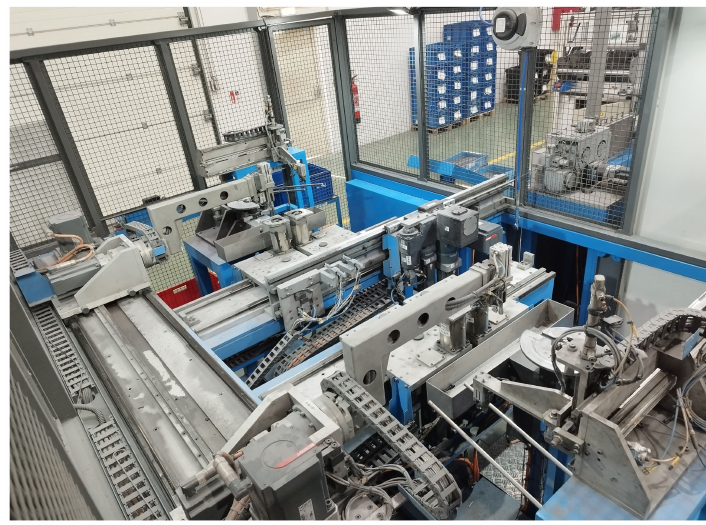
Figure 24. Image of the real equipment after